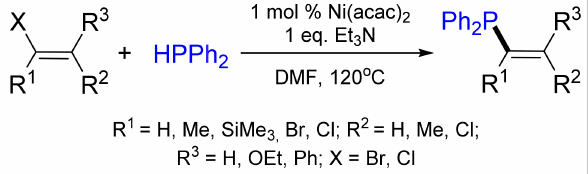
Figure 6. Nickel-catalyzed phosphination of vinyl bromides. Functionalized vinylphosphanes containing alkoxy- or amino- groups were synthe- sized by the reaction of diphenylphosphane or its trimethylsilyl derivative with the corre- sponding alkenyl bromides or chlorides under catalysis by nickel complexes. Ni complexes turned out to be more efficient than Pd complexes in reactions with less active alkenyl halides, such as 2-bromobutene and 1-bromovinylsilane [22]. Likewise, two diphenylphos- phano groups were introduced into 1 and 4 positions of 1,4-diiodo-butadienes with 90–95% yields [23] (Figure 7).